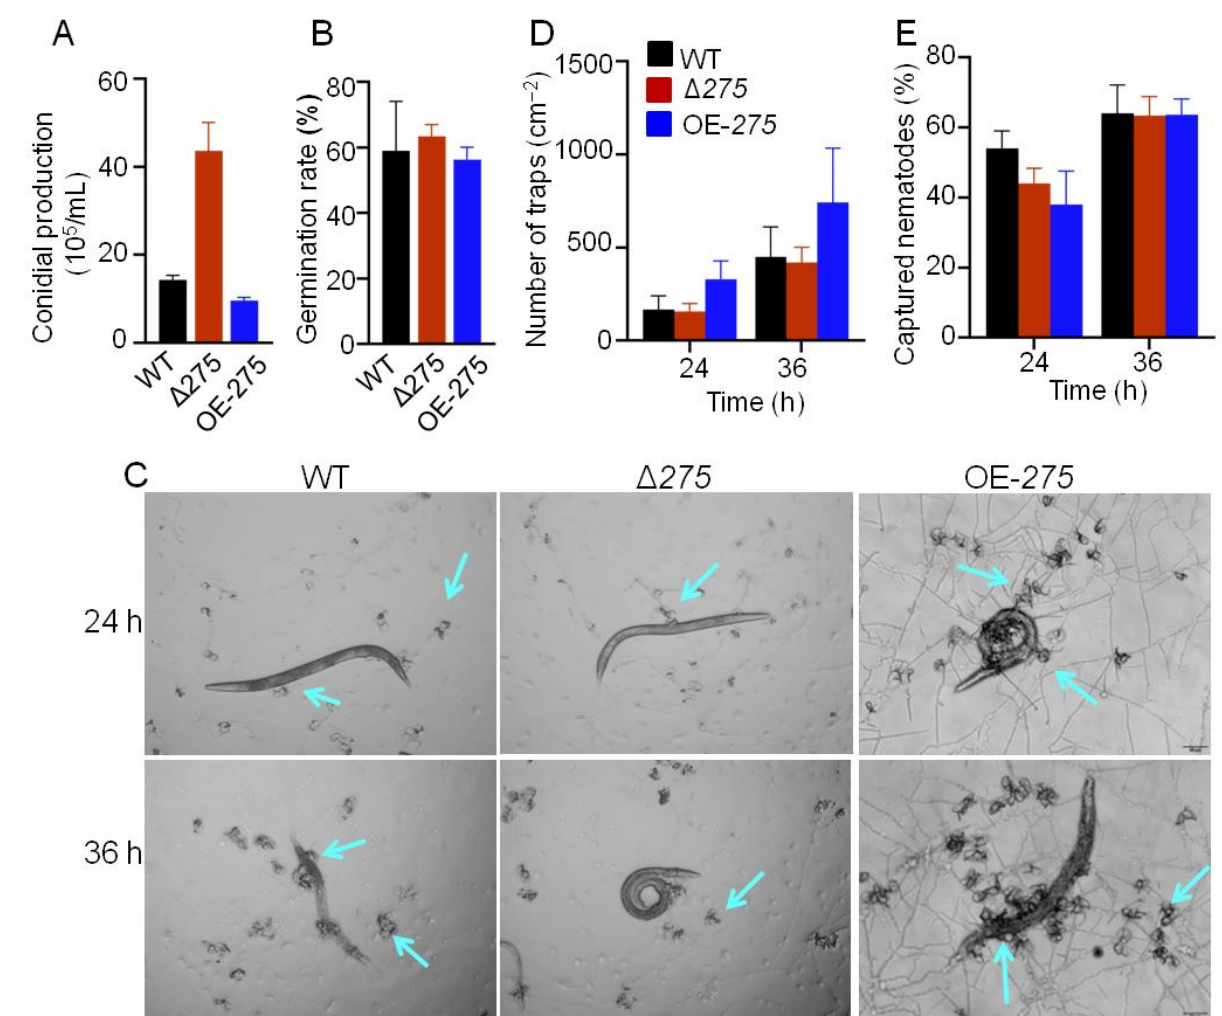
Figure 3. The effects of 275 on conidial production, germination, trap formation, and nematicidal activity: ( A – D ) Quantitative analysis of conidial production ( A ), germination rate ( B ), trap formation ( C ), and nematicidal activity ( D ), comparing the mutants Δ 275 and OE- 275 with the WT. ( E ) Comparison of trap formation nematicidal activity between the mutants Δ 275 and OE- 275 and the WT at 24 and 36 h. The arrows indicate the traps.